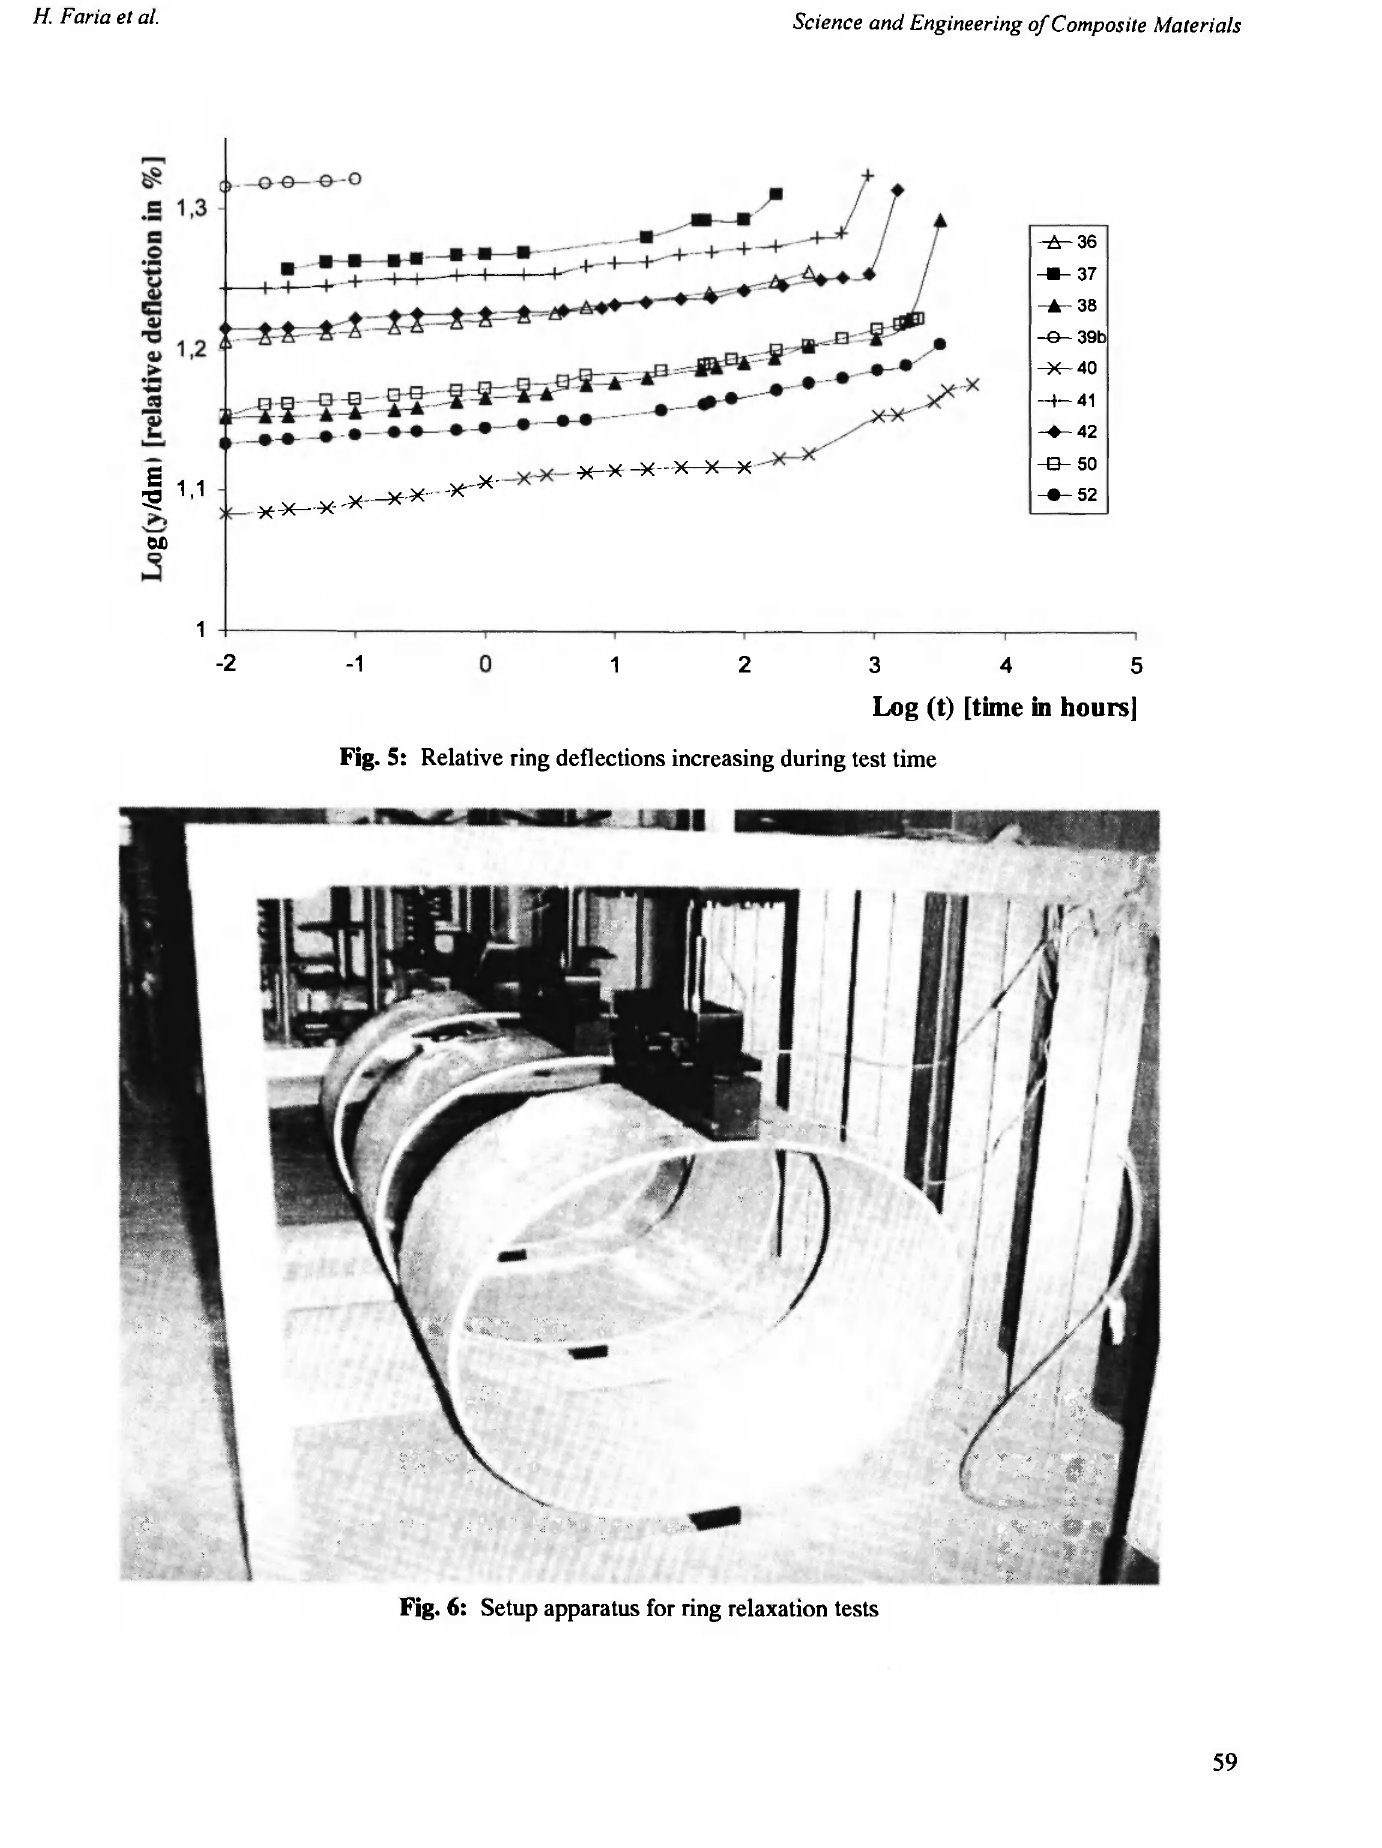
Fig. 5: Relative ring deflections increasing during test time